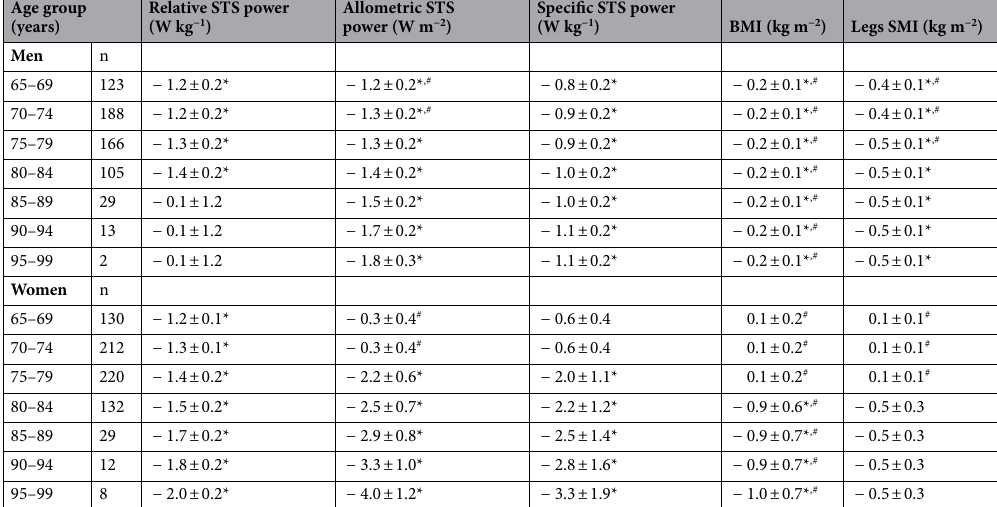
Table 2. Annual rate of change (%year −1 ) in muscle power and body composition parameters. STS sit-to- stand, BMI body mass index, legs SMI legs skeletal muscle index. *Significantly different compared with a slope equal to zero ( p < 0.05). # Significant differences between women or men at the same age ( p <